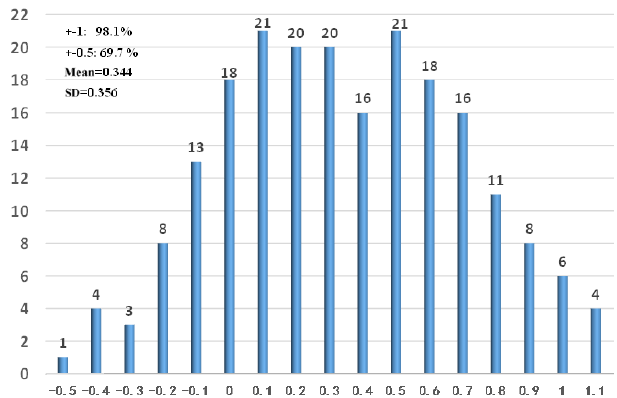
Figure 12. The seismic-intensity residuals between the observed data and simulated data.